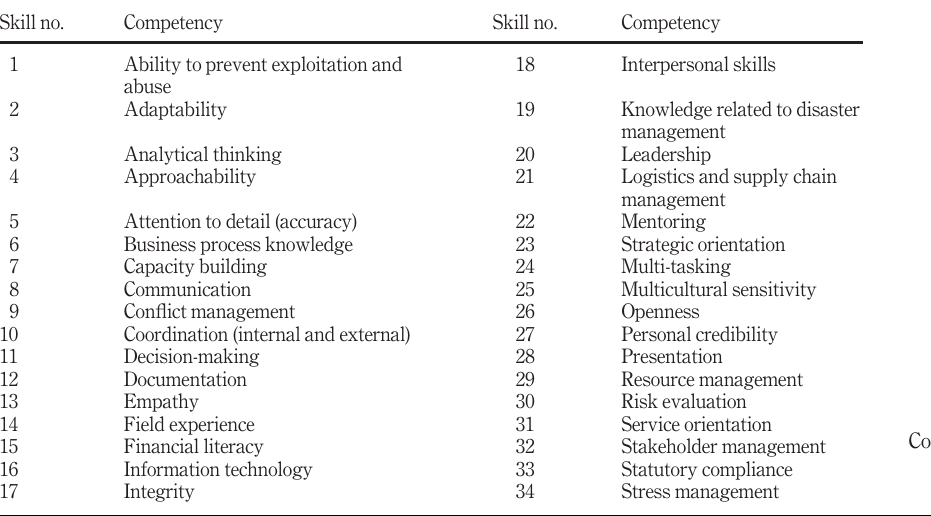
Table 2. Competencies of a humanitarian